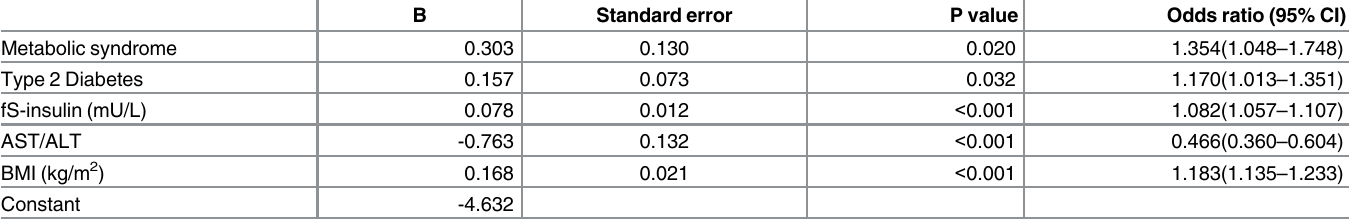
Table 3. Multivariate logistic regression model to predict NAFLD in Chinese estimation